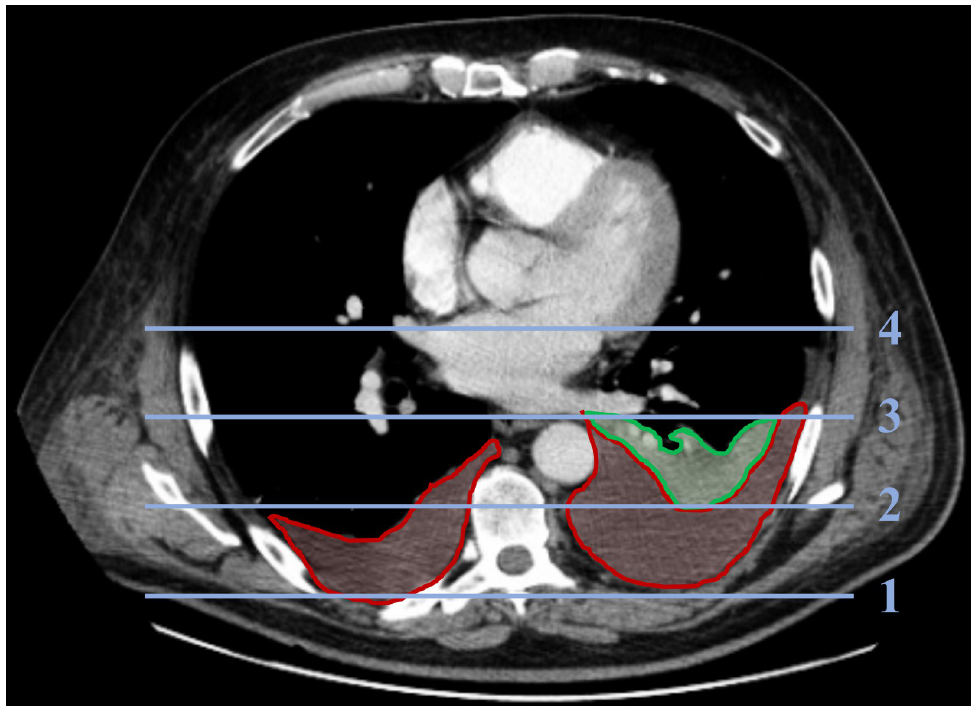
Fig 1. Exemplary representation of CECT imaging (mediastinal window) with unilateral dystelectasis (green) and severe, bilateral pleural effusions (red). Pleuropulmonary changes were analysed in the caudal sections of the thorax captured on the abdominal CECT (contrast enhanced computed tomography) scan. Thorax CECTs were additionally screened for pathologies, if available. The size of pleural effusions was determined in the transverse plane of the lung and mediastinal window. The area dorsal the midline of the thorax was divided into three parts similar in size (blue lines). Pleural effusions were classified as “low” if they remained dorsal line 2, as “moderate” if exceeding line 2, but not line 3 and as “severe” if exceeding line